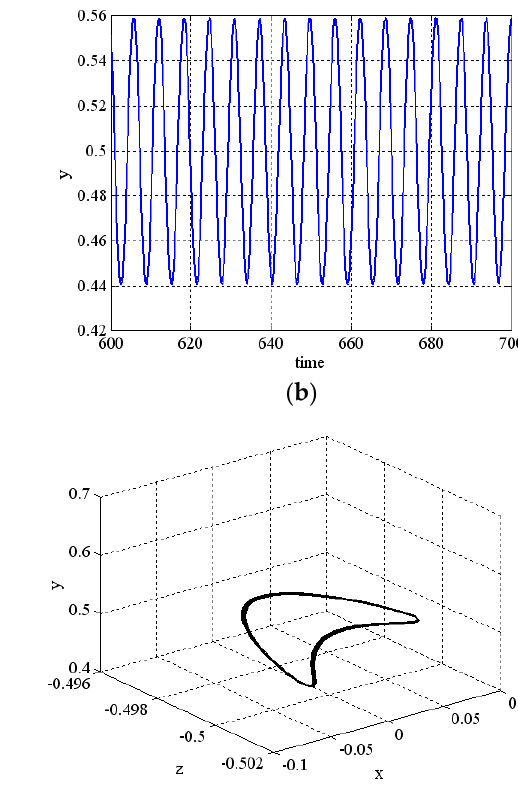
Figure 2. Bifurcation diagrams: ( a , c )